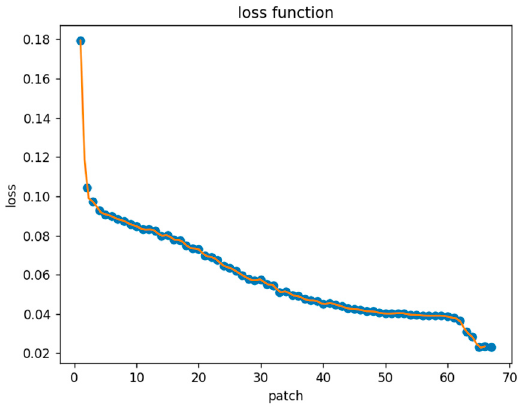
Figure 7. Loss function diagram of deep learning training. As the amount of training increases, the loss function shows a downward trend, converging on a small value, and no longer rises.